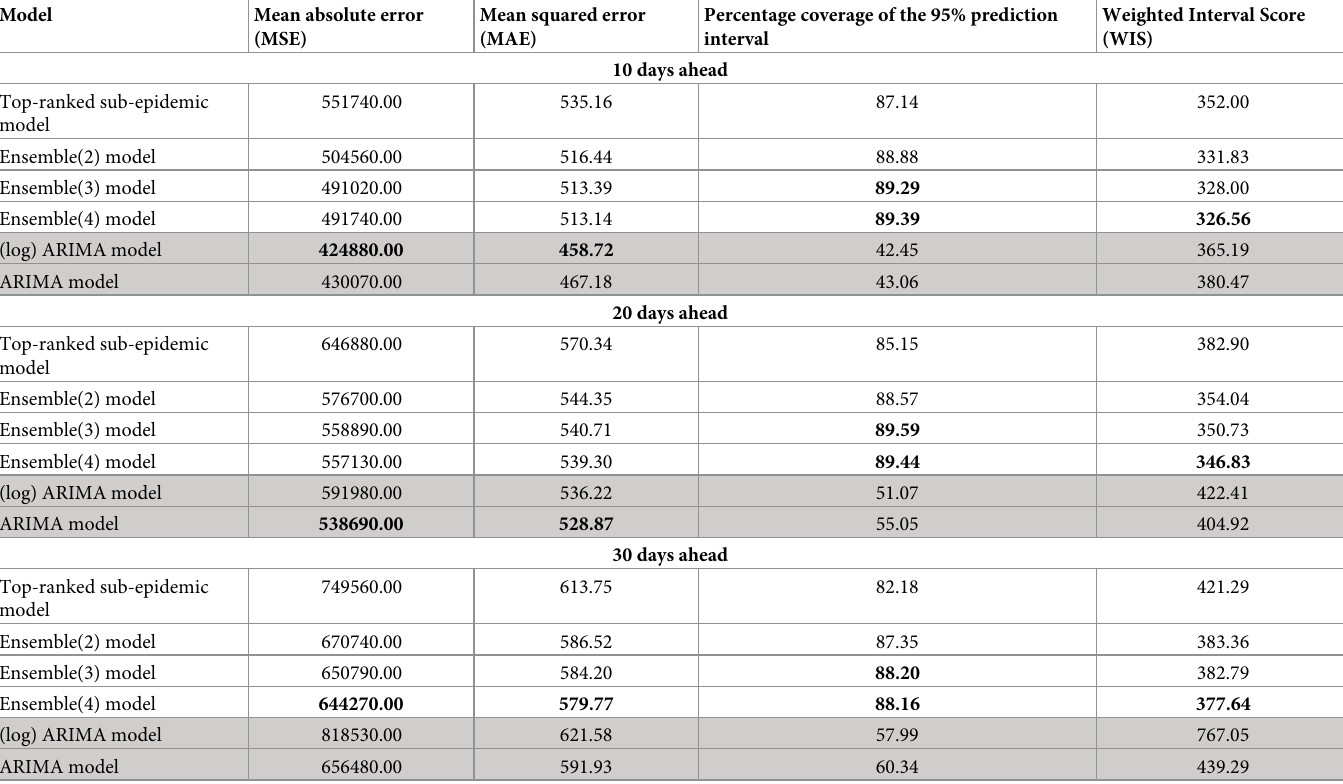
Table 2. Mean forecasting performance metrics for the sub-epidemic models (ensemble weights are proportional to the reciprocal of the AICc) and the ARIMA models across 98 sequential weekly calibration periods of the daily time series of COVID-19 deaths in the USA from 20-April-2020 through 22-February 2022. Val- ues highlighted in bold correspond to the best performance metrics.